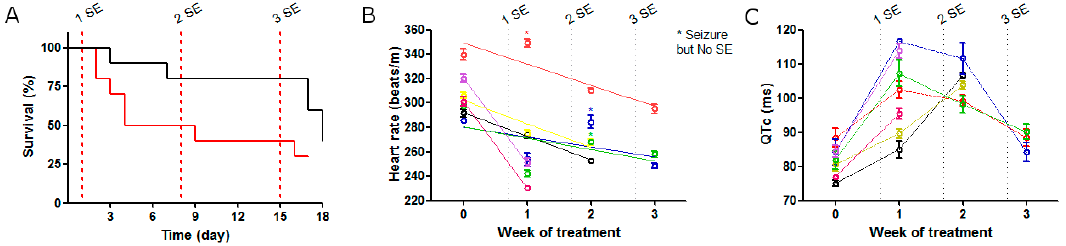
Figure 5. Analysis of multiple SE. ( A ) Survival after three weeks of treatment with SE of 15 min (black line, n = 10) or SE of 20 min (red line, n = 10). ( B ) Heart rate after each SE. Values are shown as mean ± standard deviation while lines are linear regression. Note that the heart rate was recovered when rats had seizures but had no SE (red, green and blue asterisks). ( C ) QTc-after each SE. Values are shown as mean ± standard deviation. For each plot, dashed lines represent the day of the SE.